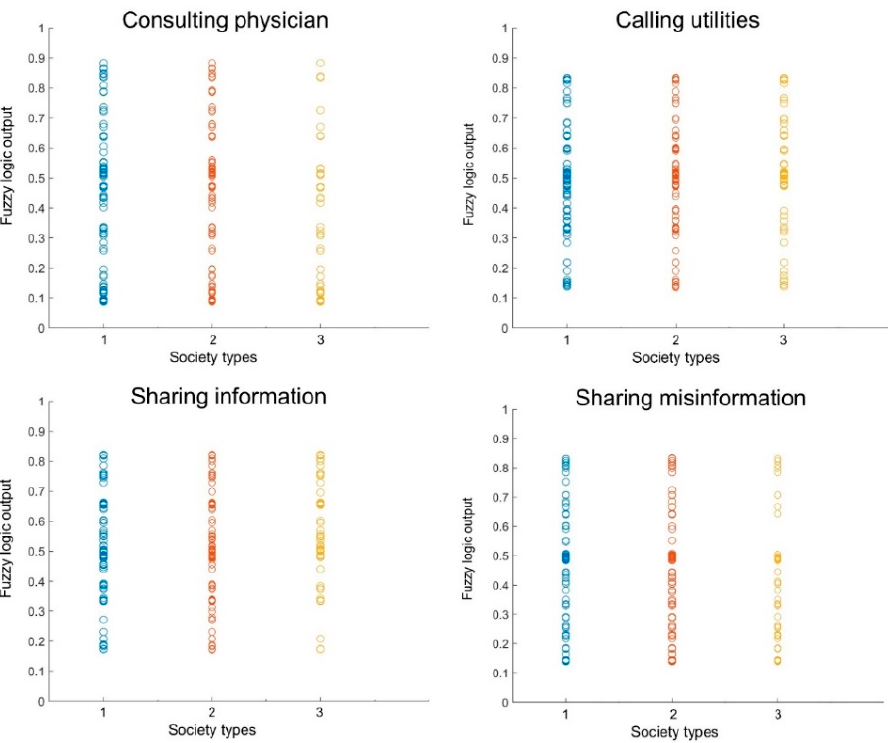
Figure 7. Scatter plot of the fuzzy logic system output in scenario one for the three different society types and the four different possibly taken actions.